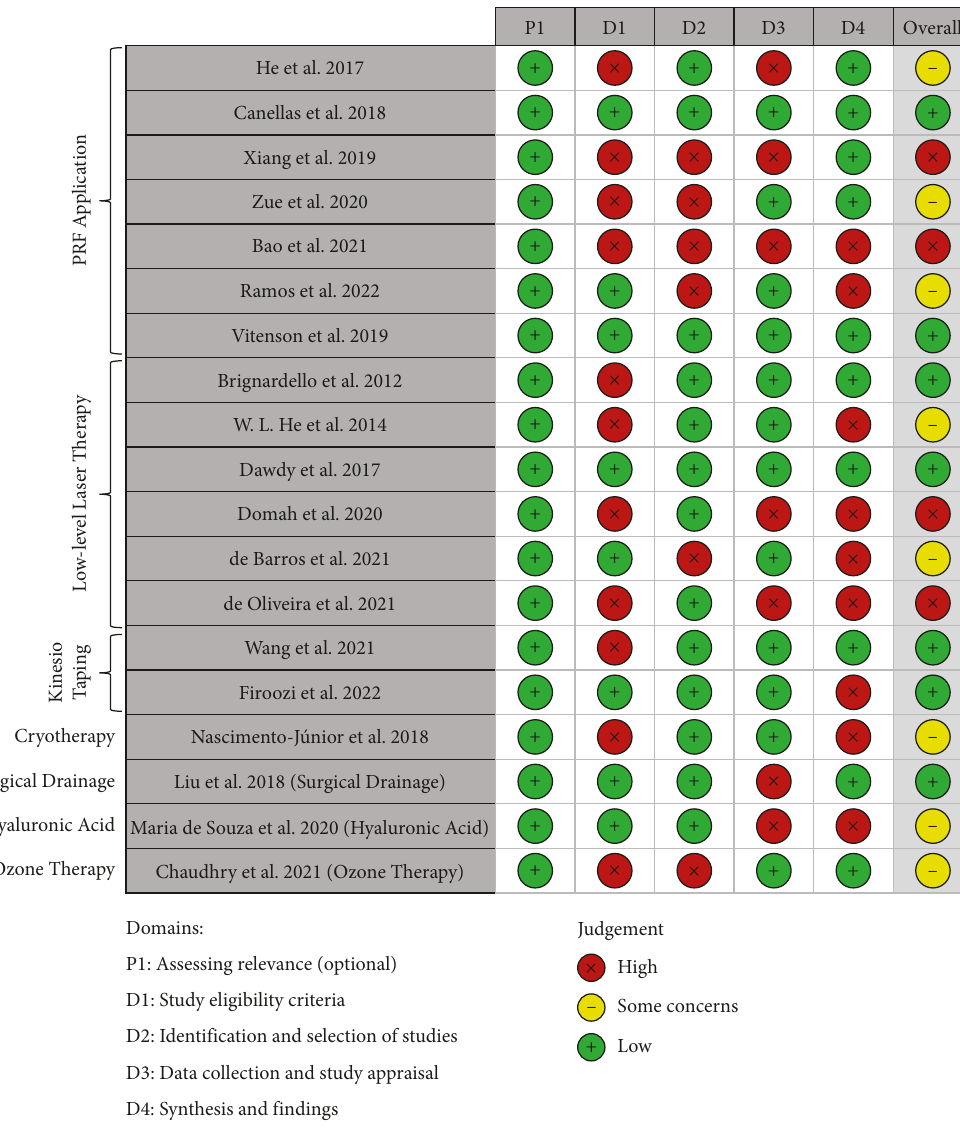
Figure 2: Risk of bias